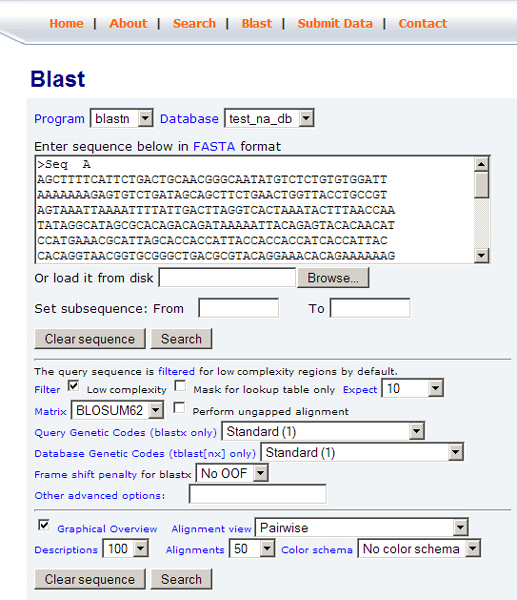
Screenshot of the local BLAST page with default options.